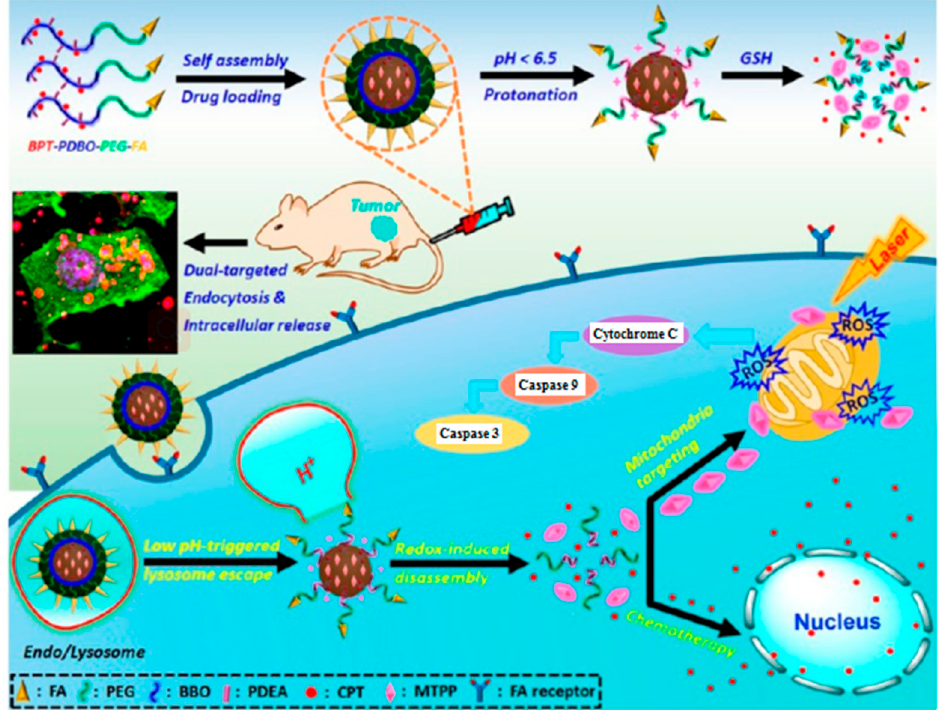
Figure 5. Illustration of cascade-responsive disassemble micelles with dual-targeting capability for tumor therapy in vivo. Copyright (2017) American Chemical Society [101].